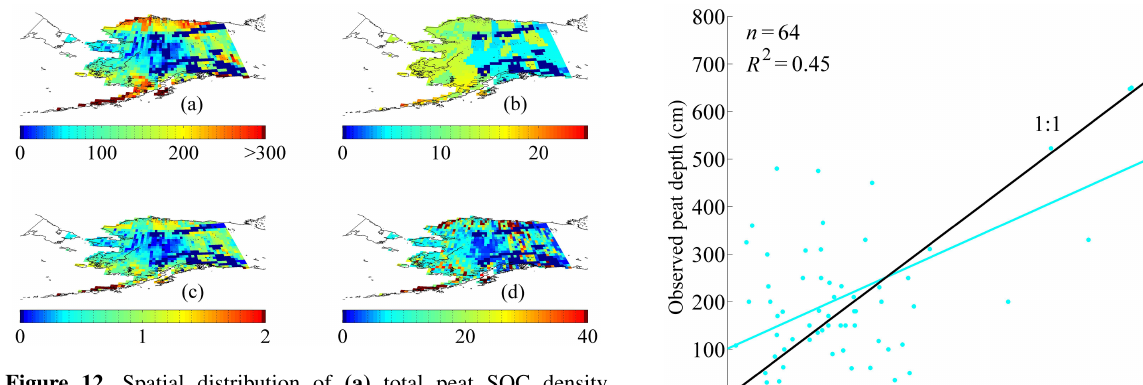
Figure 12. Spatial distribution of (a) total peat SOC density (kgCm − 2 ) , (b) total mineral SOC density (kgCm − 2 ) , (c) to- tal peat depth (m), and (d) area-weighted total (peatlands plus non-peatlands) SOC density (kgCm − 2 ) in Alaska from 15ka to 2000AD. Figure 13. Field-based estimates and model simulations for peat